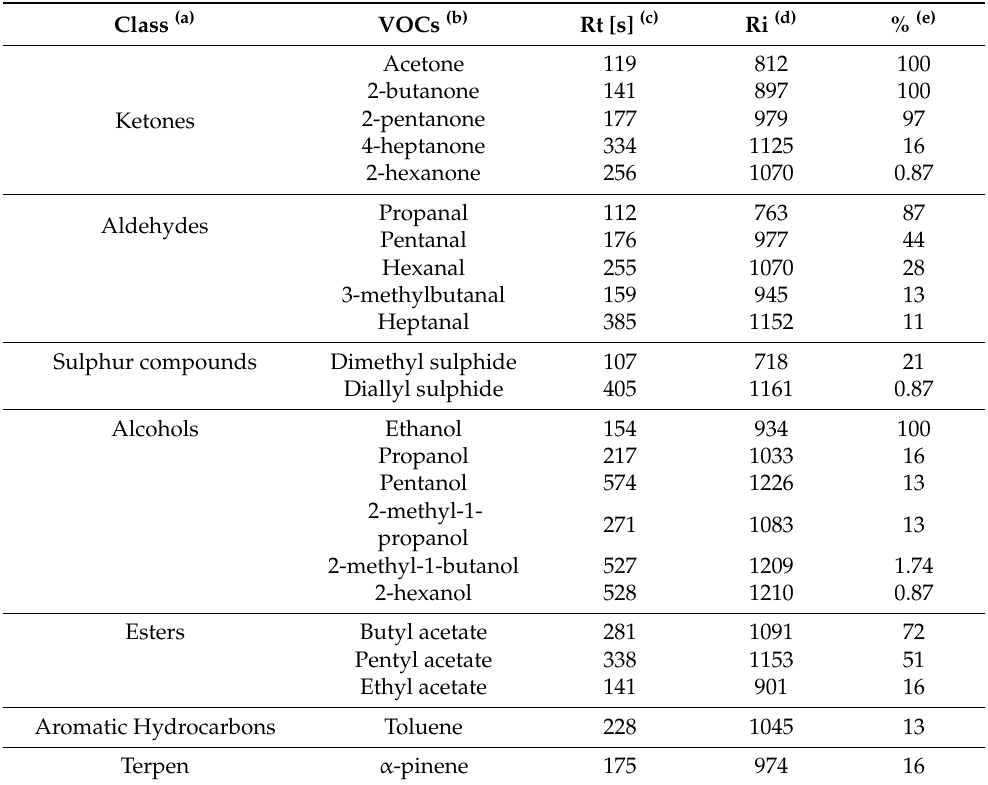
Table 3. Summary of VOCs detected across the population in urine samples. (a) class of molecule to which the VOC belongs; (b) list of detected VOCs; (c) retention time (Rt) to which the VOC was eluted; (d) retention index (Ri) of VOC calculated by the VOCal software; (e) percentage of the population in which VOCs were detected.